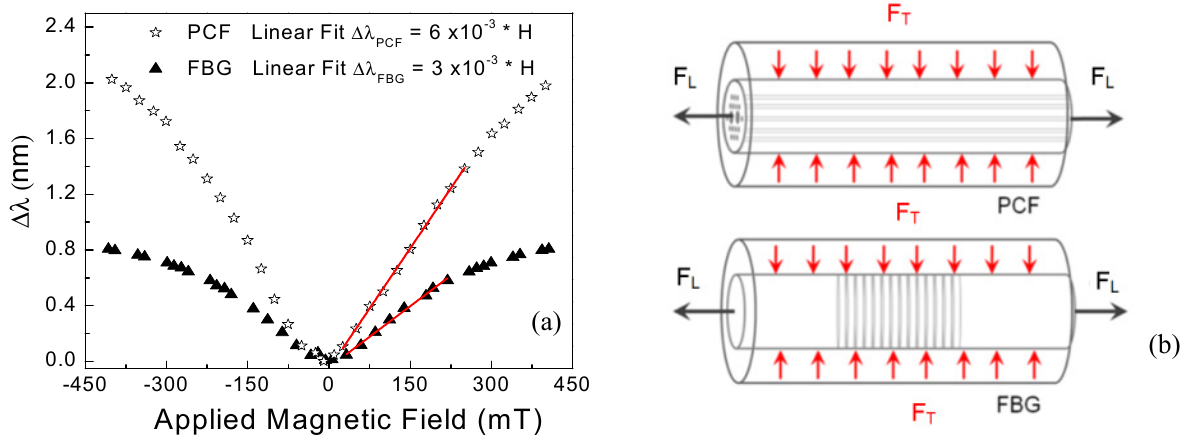
Figure 3. ( a ) Response of the two optical fiber sensors to magnetic field, white stars is the HiBi PCF fiber modal interferometer and black triangles the fiber Bragg grating; ( b ) Schematic representation of the forces acting on the optical fiber sensors. Black arrows indicate the elongation strain and the red arrows the resulting transversal compression forces induced both as a result of the magnetostrictive composite elongation for solid fiber with a Bragg grating and photonic crystal